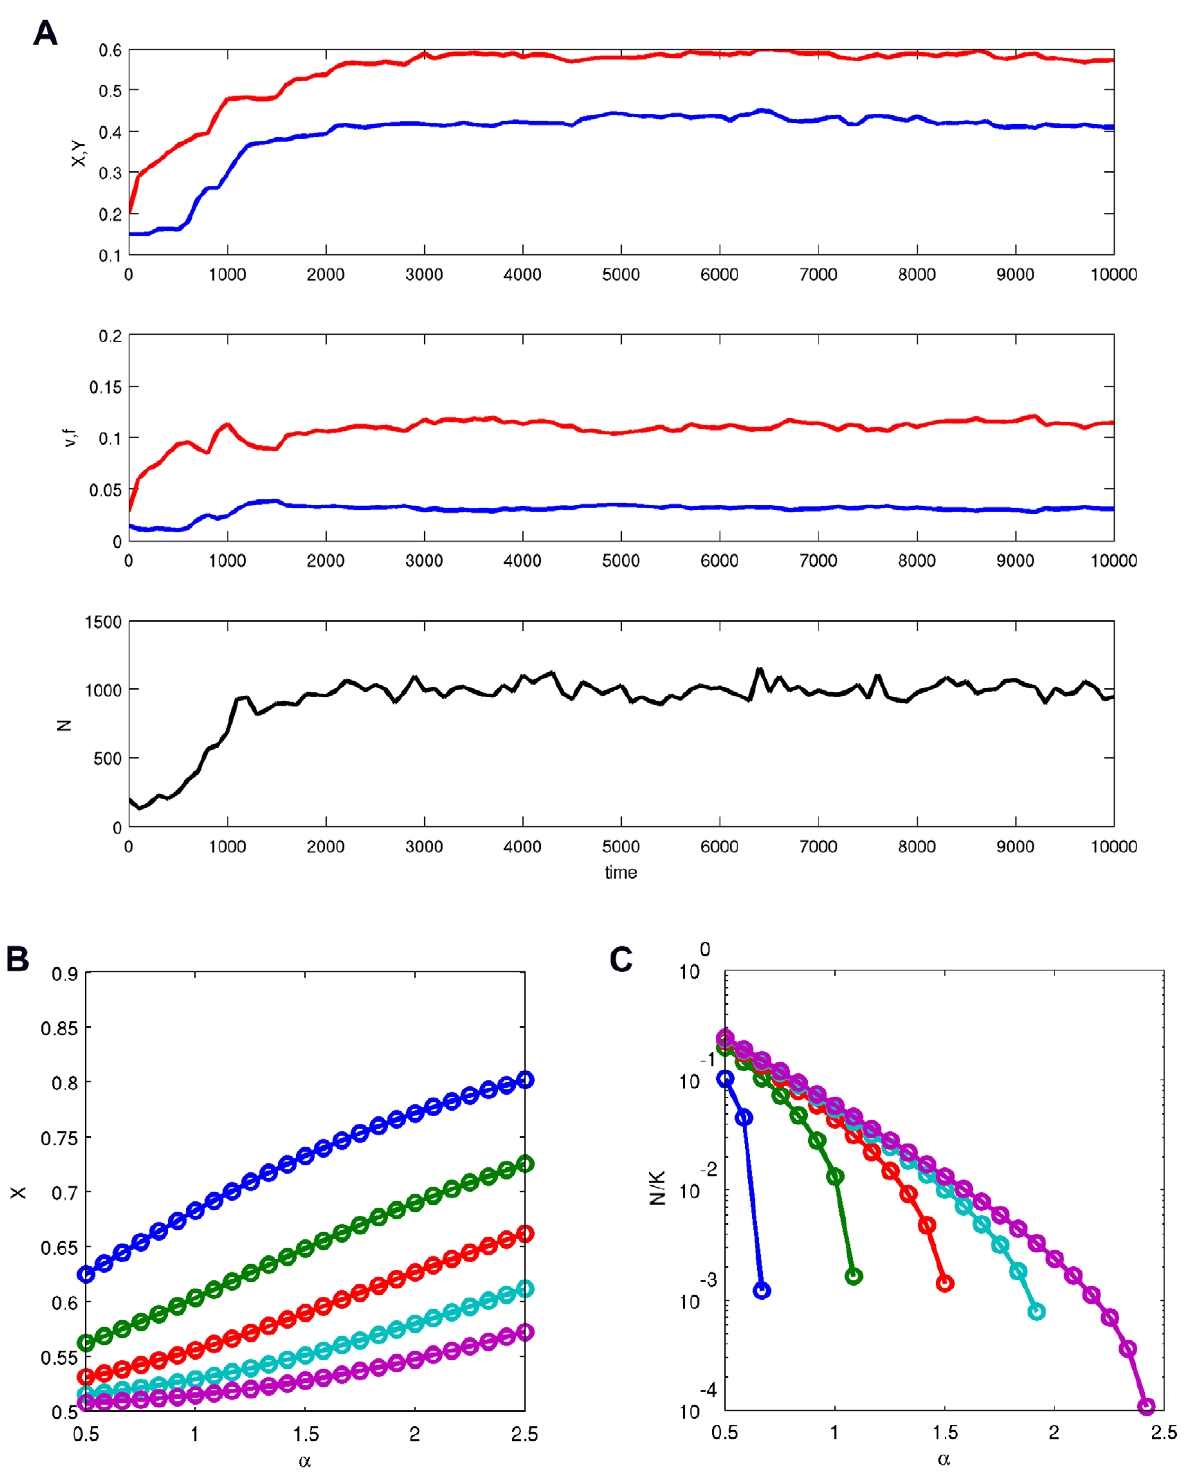
Figure 1. Evolution in major loci. (A) An example of the model’s dynamics with a ~ b ~ 2 ; m ~ 0 : 001 ; K ~ 380,060 . Shown are at top: the average values of X (red) and Y (blue), middle: the average fertility f (red) and viability v (blue), and bottom: the number of colonies N in the system. (B) The equilibrium values of X for different a and S ~ 4 (blue),8, 16, 32 and 64 (pink). b ~ a , so that Y ~ 1 { X . (C) The relative equilibrium population size N = K for the same values of parameters as in (b).